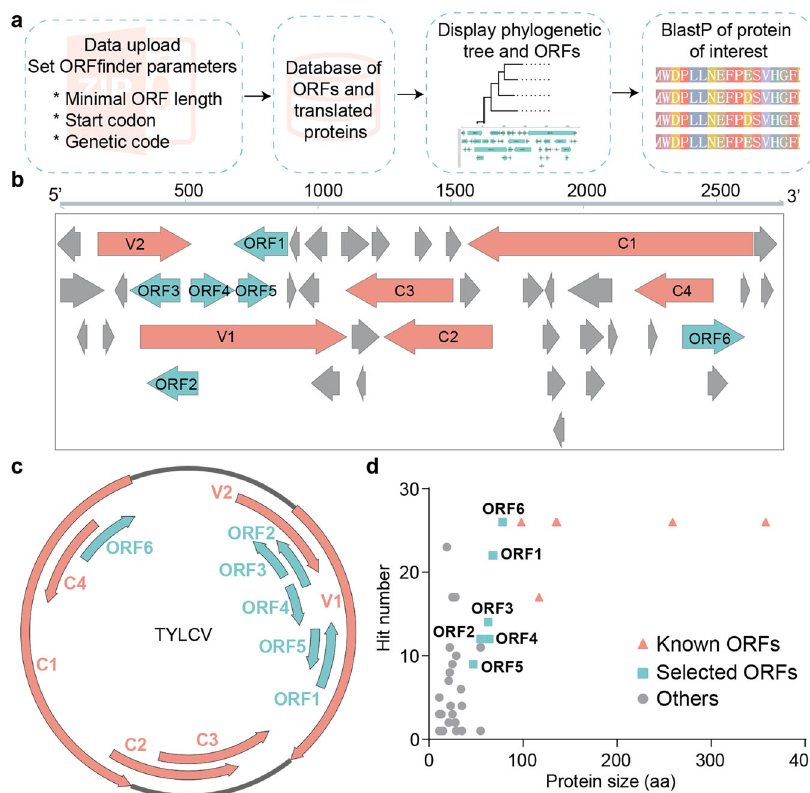
Fig. 1 The TYLCV genome contains additional conserved open reading frames. a Working pipeline of ViralORF fi nder, a web-based tool for ORF prediction and protein conservation analysis. b Schematic view of predicted ORFs ( ≥ 30 nt) in the TYLCV genome. c Genome organization of TYLCV; arrows indicate ORFs. In ( b ) and ( c ), pink arrows represent the six known ORFs (C1, C2, C3, C4, V1, and V2), while blue arrows represent the six additional ORFs described in this work (ORF1-6). d Correlation between the size of proteins encoded by the ORFs in the TYLCV genome and their representation in the selected subset of begomoviruses (see Supplementary Table 6). The TYLCV isolate used in these experiments is